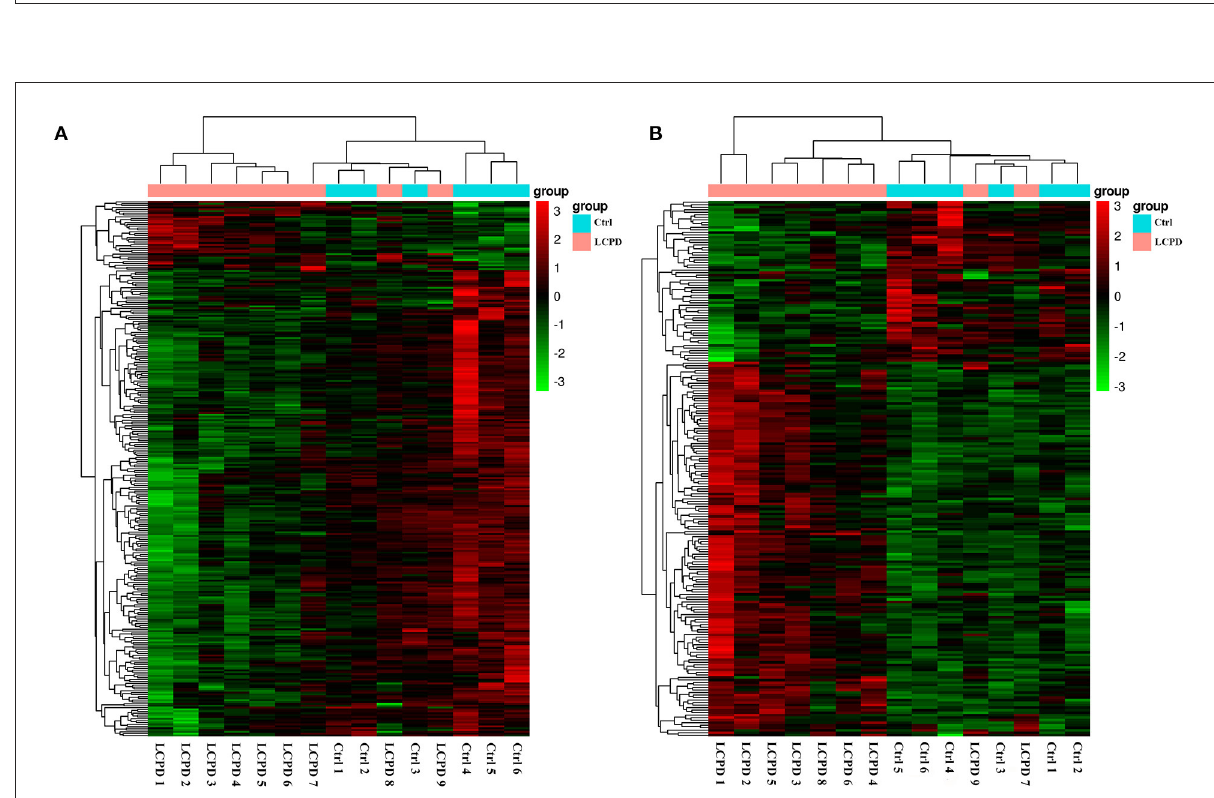
FIGURE2 Hierarchical clustering analysis showed the differentially expressed mRNAs (A) and lncRNAs (B) . The abscissa represents the samples, and the ordinate represents the differentially expressed genes. Red color represents the differentially expressed genes with high expression value, while green color with low expression